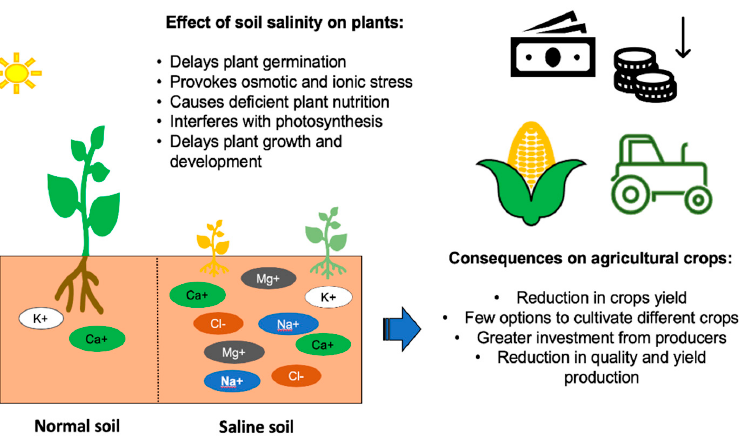
Figure 1. Effect of salts excess on plants and agricultural crops. Horizontal arrow: consequences of saline soils on agricultural crops. Vertical arrow: reduction of money gain.